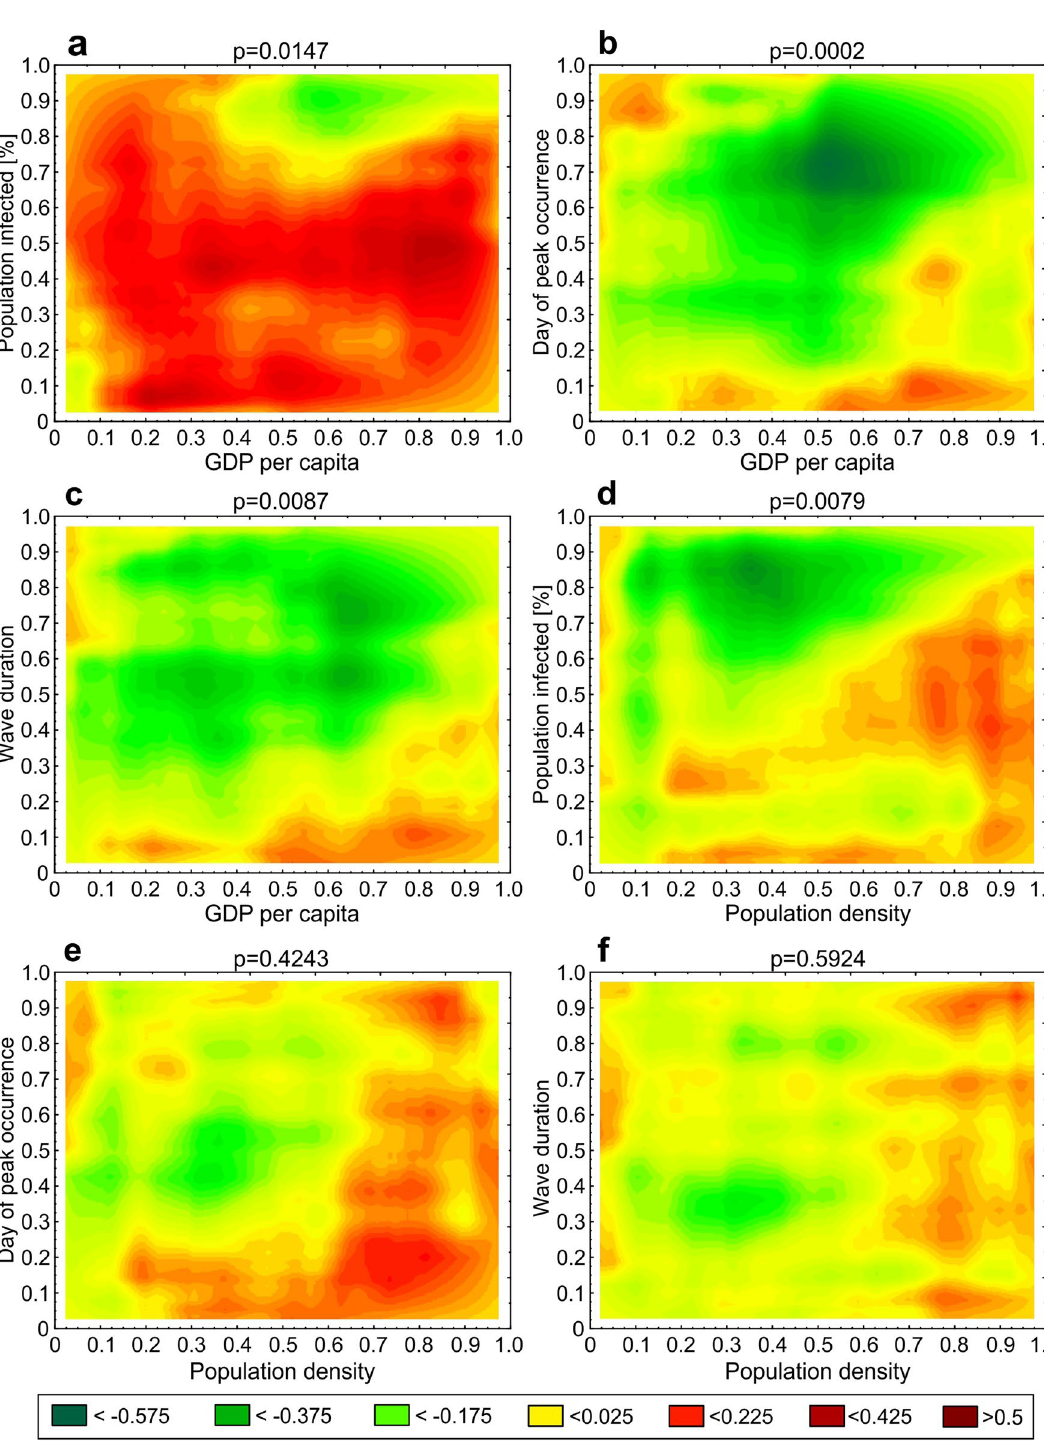
Figure 4. Heat maps showing p values and the local association structure between variables at different quantile levels obtained using the quantile dependence function